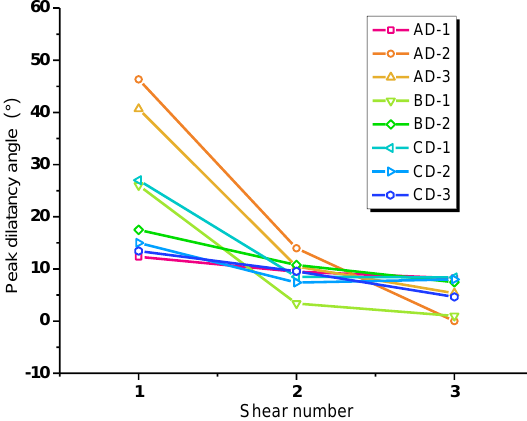
Figure 11. Relationship between shear times and peak dilatancy angle d n .